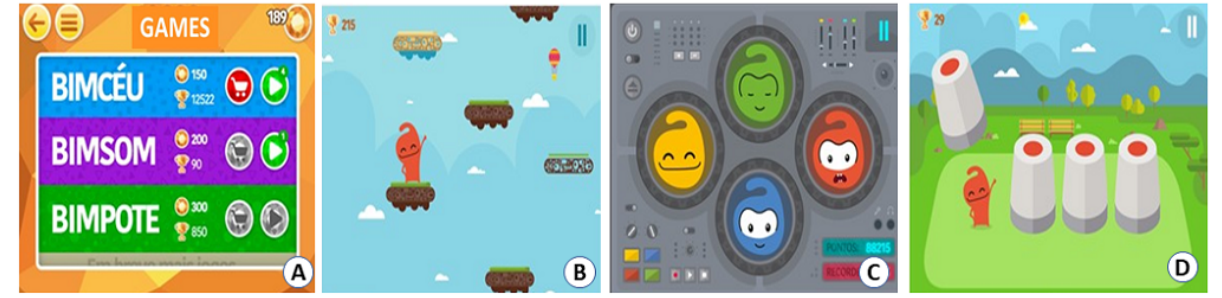
Figure 6. Bonus mini games. A: home screen; B: BIMCEU, a mini-game that stimulates motor coordination by ascending platforms and avoiding obstacles; C: BIMSOM, which requires the repetition of an increasingly complex sequence of sounds and colors until the final level is reached; D: BIMPOTE, which encourages memory while searching for the character.